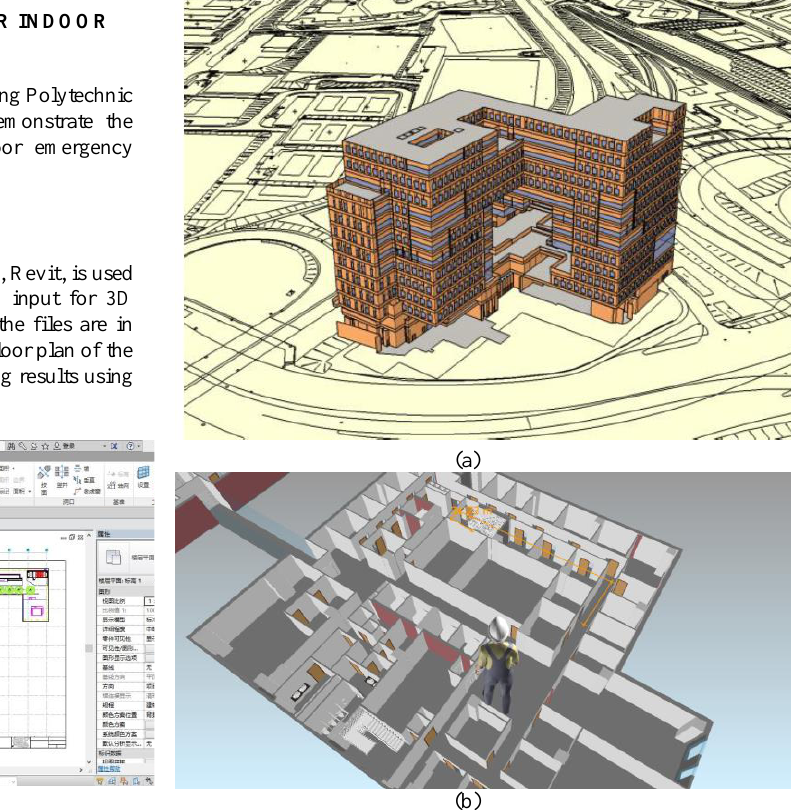
Figure 3. 3D model of the text sit. (a) Geo-referenced 3D model on a 1:1000 base map, and (b) a detailed view of the indoor